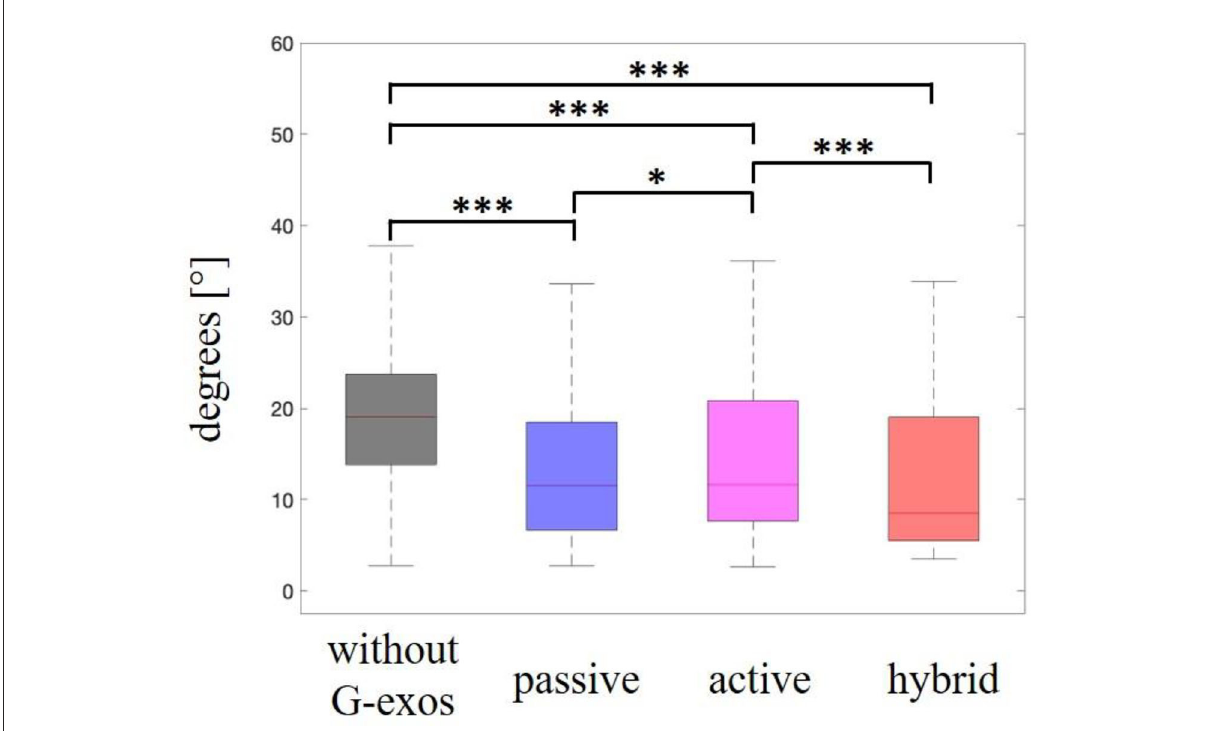
FIGURE11 Range of motion of ankle inversion/eversion in patients with a foot drop. Statistically significant differences are shown with the stars (* p -value < 0.05, *** p -value < 0.001). Here, we see a comparison of range of motion of ankle inversion/eversion without the use of the G-Exos, with the passive system, with the active system, and with the hybrid system (active and passive). Median represented in the second quartile.